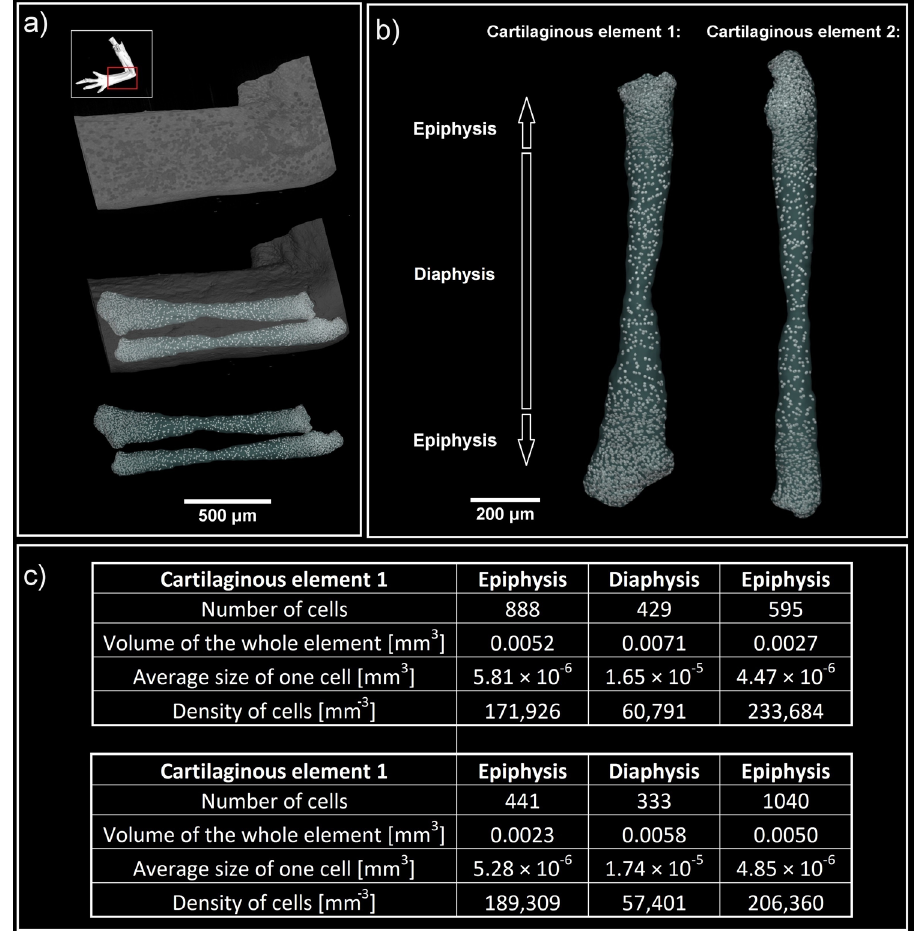
Figure 3. ( a , b ) 3D visualization of cartilaginous elements from a developing P . waltl limb forearm. White spots represent cell nuclei. c) Quantitative analysis allowed the determination of cell number, average size (given by ratio of volume of the whole element and number of cells), density and the volume of each cartilaginous element. The difference between diaphysis and epiphysis is evident: the density of cells in the diaphysis is half in comparison with the density in the